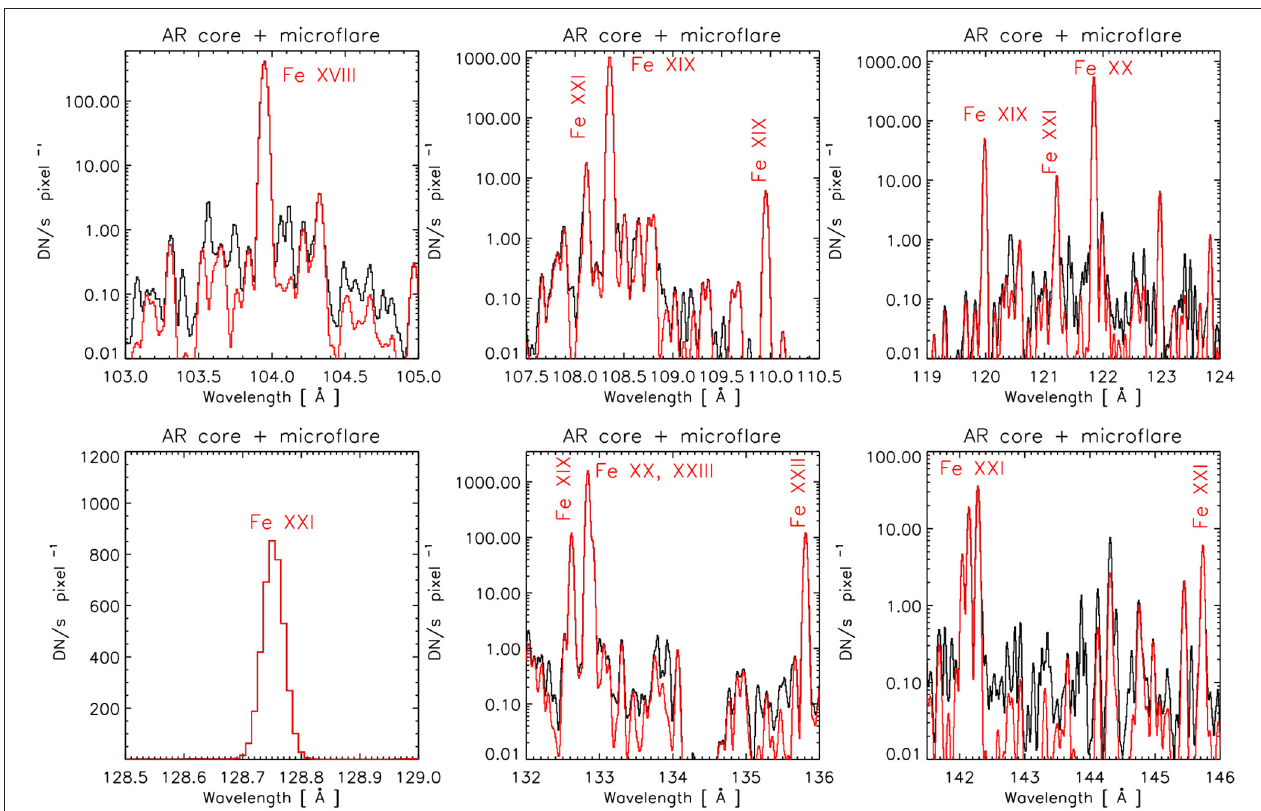
FIGURE 8 | Simulated SXR count rates (1 ′′ pixel) for an 8 MK A-class microflare (red spectrum), added to those of an active region core. The black spectrum is the sum of the two.